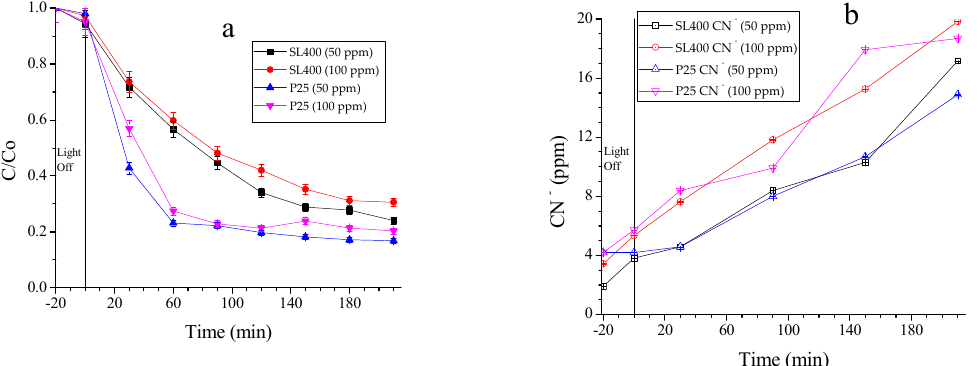
Figure 7. ( a ) Cyanocomplex degradation; ( b ) Free cyanide released. Operating conditions: 0.5 L / min of air bubbled, 0.5 g cat / L solution, 3.5 h of reaction with 30 min of adsorption and power supply of 20 W.